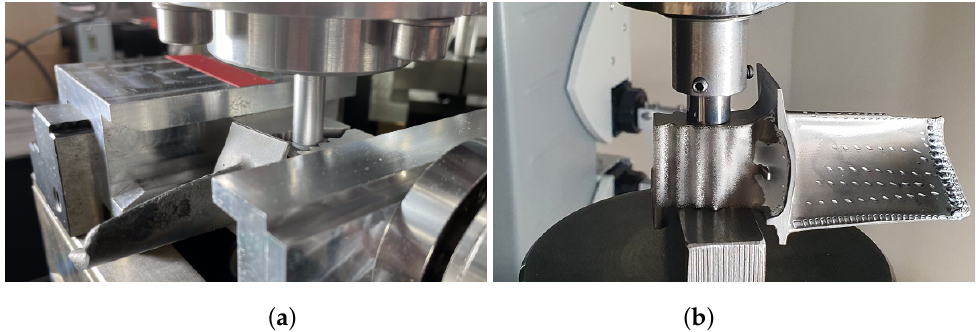
Figure 13. Transfer of the disassembly test setup to the analysis of the maximum load. ( a ) Design of the disassembly test rig: the ram exerts the disassembly force on the blade root. ( b ) Experimental setup of the load